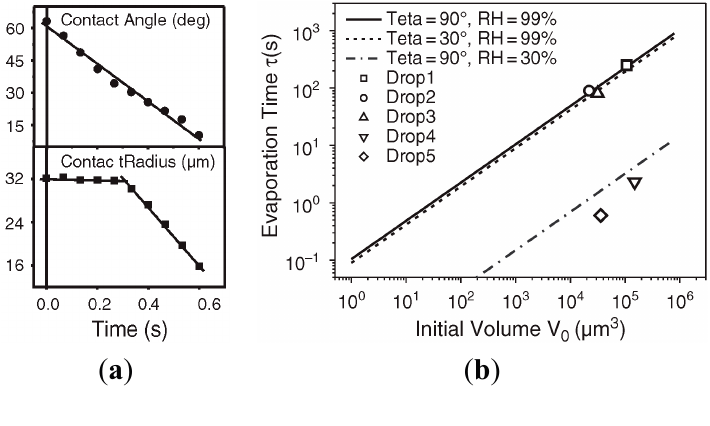
Figure 24. ( a ) Evaporation of a water droplet of 32 microns radius on a silicon surface with time at 25 °C, 30% RH, contact angle of 63° and surface tension of 72 mN/m, the contact angle is in the top panel and the contact radius is in the bottom; ( b ) Evaporation time with initial volume for different contact angles and RH